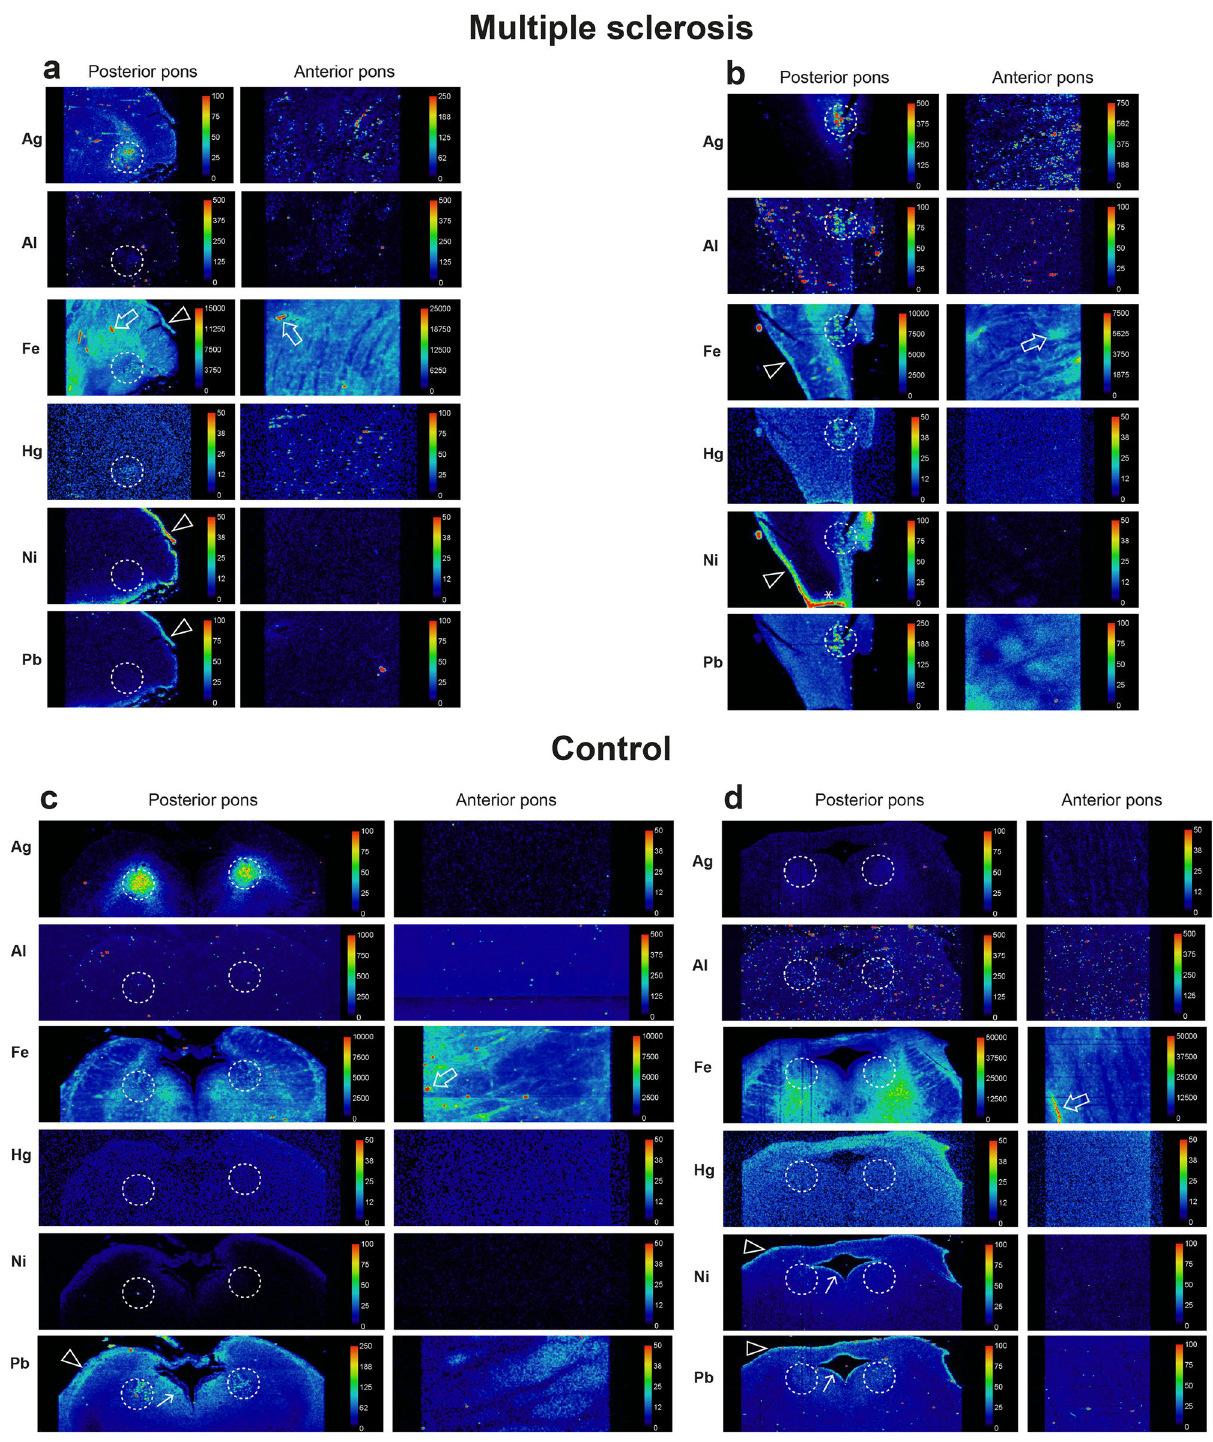
Figure 9. Representative images of LA-ICP-MSI in MS and control pons samples II. The position of the locus ceruleus is within the dashed circles. ( a ) MS09. Posterior pons : locus ceruleus MSI PTEs are silver, iron, and mercury. Iron is also present in non-locus ceruleus regions (green), and in and around small blood vessels (arrow). Iron, lead, and nickel are seen in the leptomeninges and subpial regions (arrowheads). Anterior pons : iron and mercury are present in linear regions (possibly blood vessels), and iron in and around blood vessels (arrow). (b) MS18. Posterior pons : locus ceruleus MSI PTEs are silver, aluminium, iron, mercury, nickel, and lead. Iron is also present in non-locus ceruleus regions (green). Iron and nickel are seen in subpial regions (arrowheads), with nickel on a cut surface (*). Anterior pons : silver, iron and lead are present in linear regions, and iron (green) around blood vessels (arrow). ( c ) CN08. Posterior pons : locus ceruleus MSI PTEs are silver, iron, and lead. Iron is present in extra-locus ceruleus regions. Lead is seen in subpial (arrowhead) and subependymal (thin arrow) regions. Anterior pons : Iron in present in linear regions and around blood vessels (arrow). Linear deposits of iron and lead are present. ( d ) CN02. Posterior pons : locus ceruleus MSI PTEs are iron and lead. Iron is also present in extra-locus ceruleus regions (green). Small amounts of lead and nickel are seen in subpial and subependymal regions (thin arrows). Anterior pons : Linear silver and iron, and iron in and around blood vessels (arrow), are